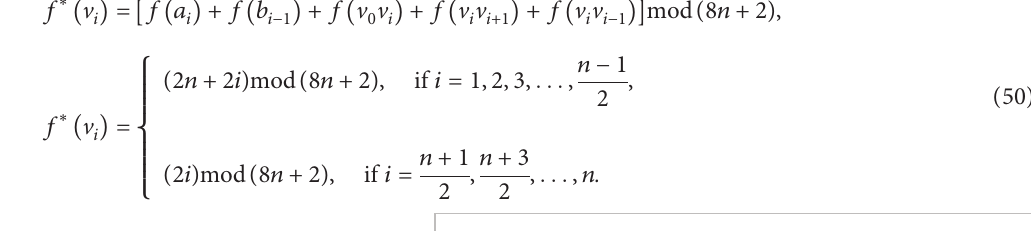
. (b) 2-edge even graceful labeling of SF 9